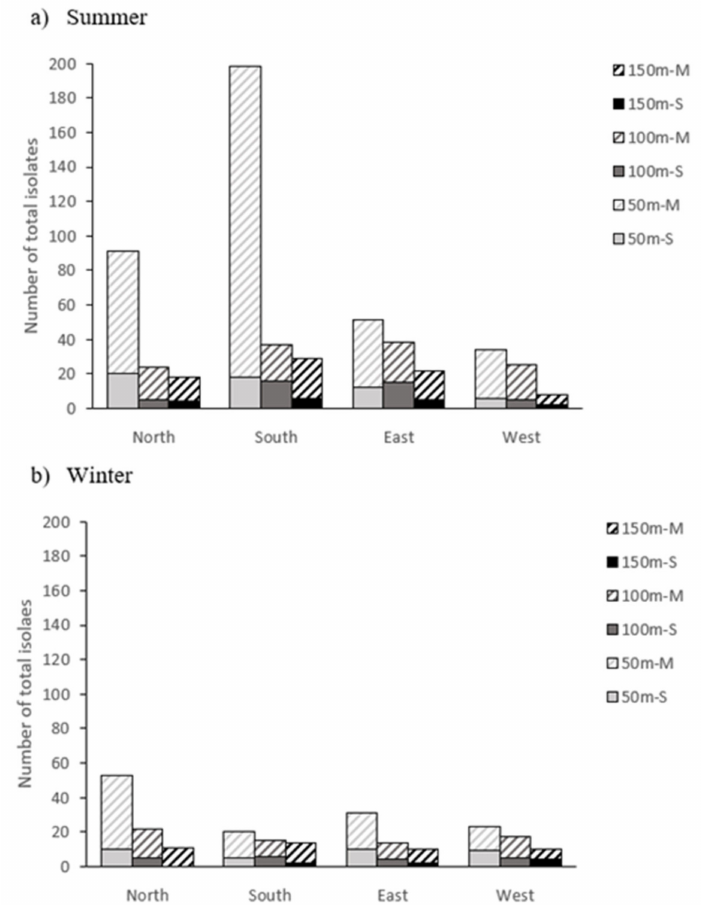
Figure 1. Distribution of total bacterial isolates obtained in the outside air of the broiler farm using both sampling methods (M, mechanical; S, stationary) in relation to the distance (50, 100 and 150 m) from the farm and the cardinal direction in summer ( a ) and winter ( b